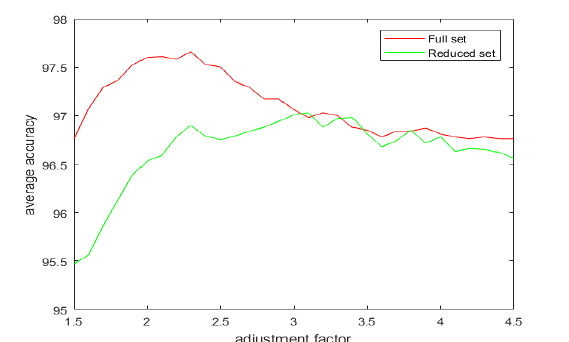
Figure 11. The average accuracy versus the adjustment factor for the full and the reduced Wisconsin Breast Cancer dataset.